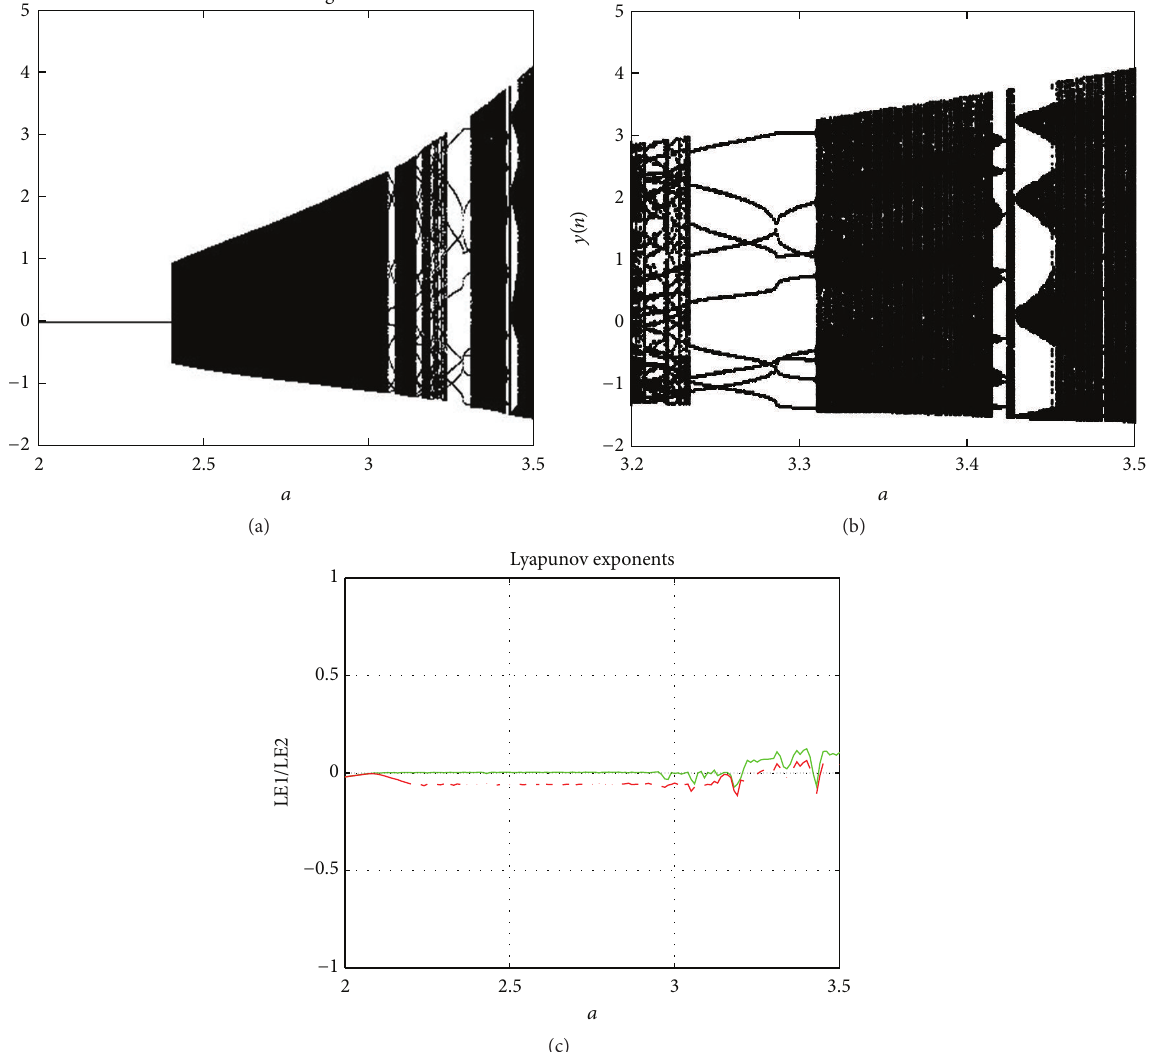
Figure 1: (a) Bifurcation diagram of system (1) when initial values are 𝑥(1) = 0.01 and 𝑦(1) = 0.01 . (b) Local amplification corresponding to (a). (c) Lyapunov exponents corresponding to